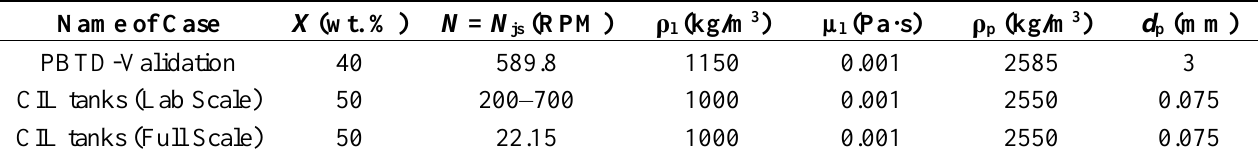
Table 3. Conditions in stirred tanks used for